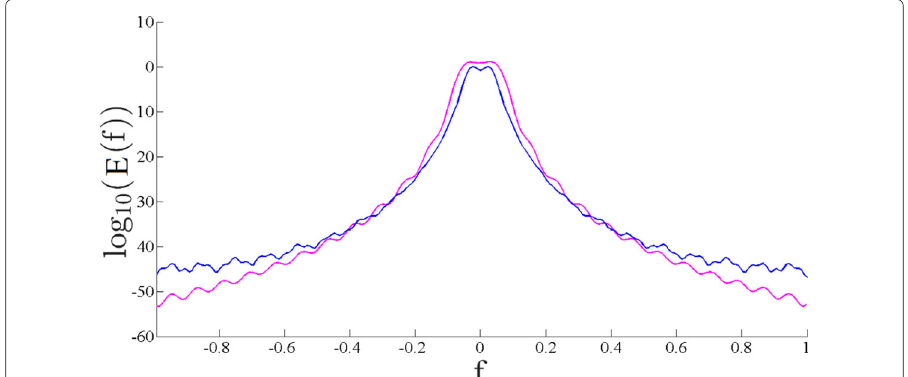
Fig. 10 Log of the estimated Fourier transform in dB, as a function of the frequency f ( × π rad/s ) , obtained by the Welch method (blue) versus the one obtained with the proposed expression (lilac) for the derivative of the impulse response of the Liljencrants-Fant glottal model